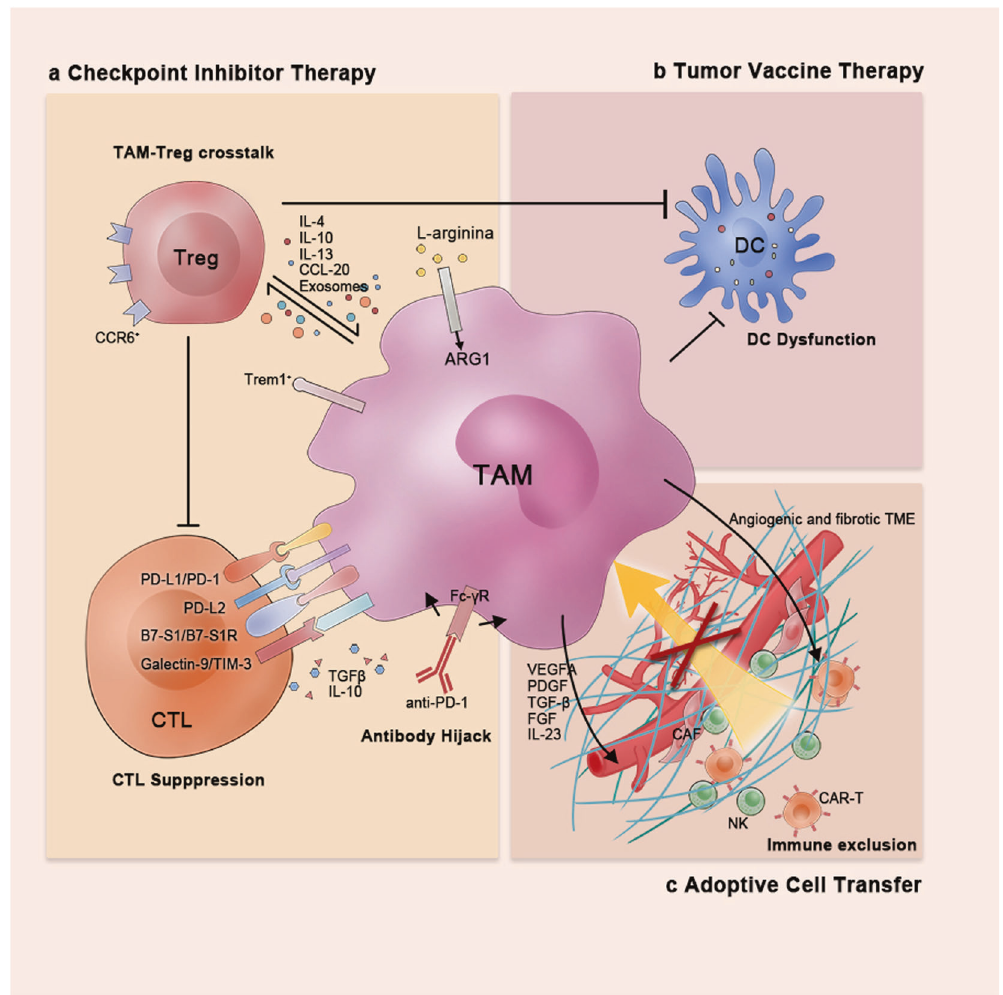
molecules and immunosuppressive cytokines and indirectly through crosstalk with Tregs and hijacking of anti-PD-1 antibodies. b In tumor vaccine therapy, TAMs can inhibit the antigen-presenting ef fi ciency of dendritic cells; c In adoptive cell transfer therapy, TAMs prevent immune in fi ltration via build up the highly fi brotic and angiogenic